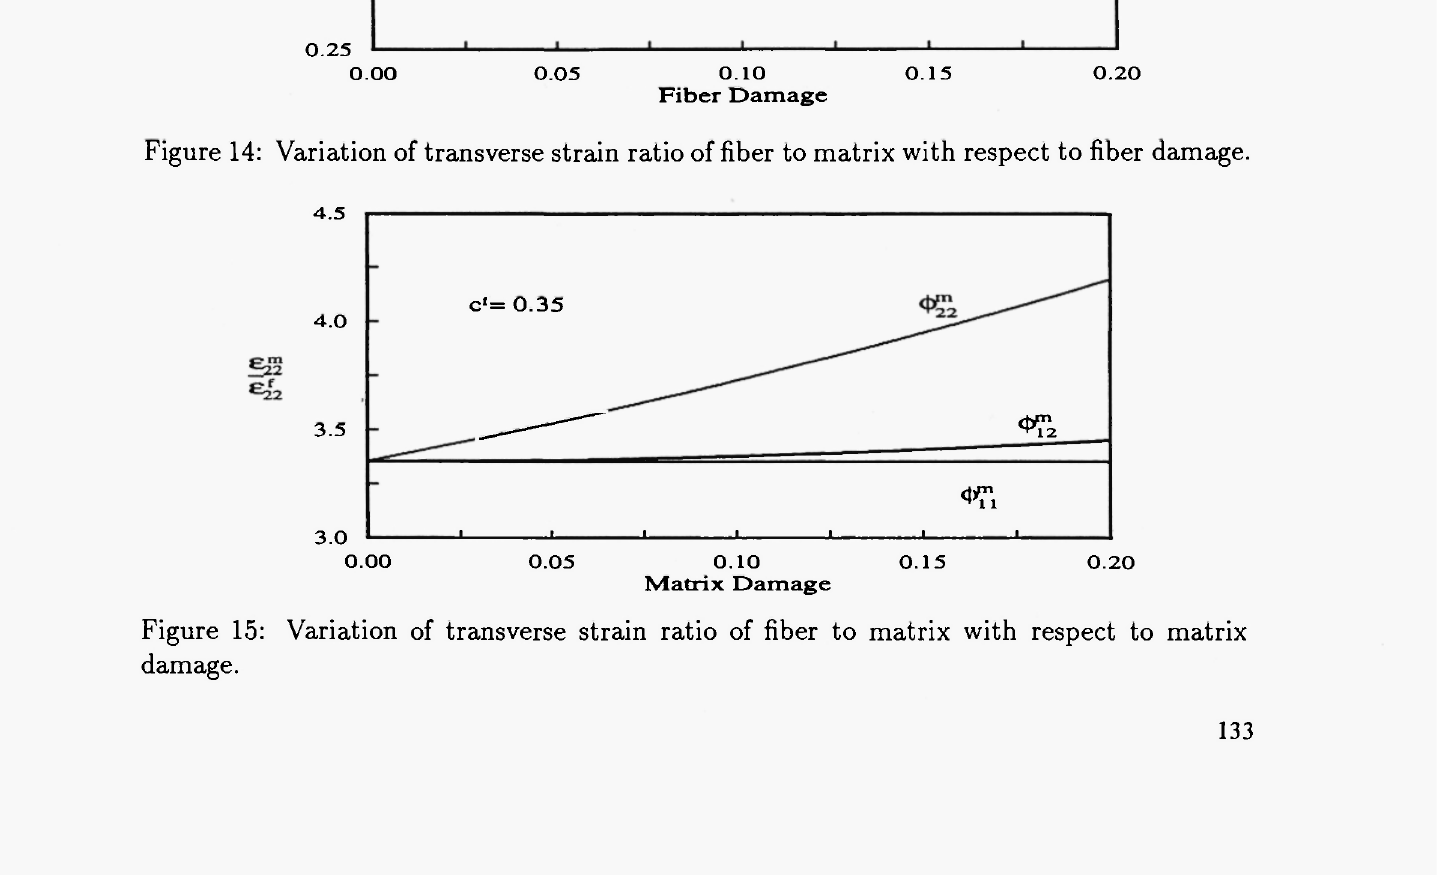
Figure 14: Variation of transverse strain ratio of fiber to matrix with respect to fiber damage.